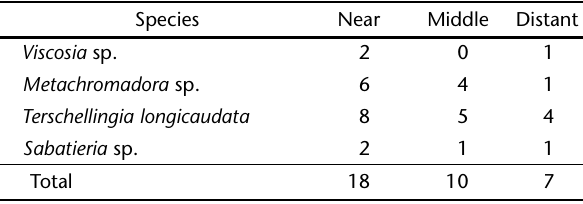
Table III. Number of stained nematodes found in the nets placed in the water column after a flood tide. Net Species Low High Near Distant Near Distant Viscosia sp. Metachromadora sp.